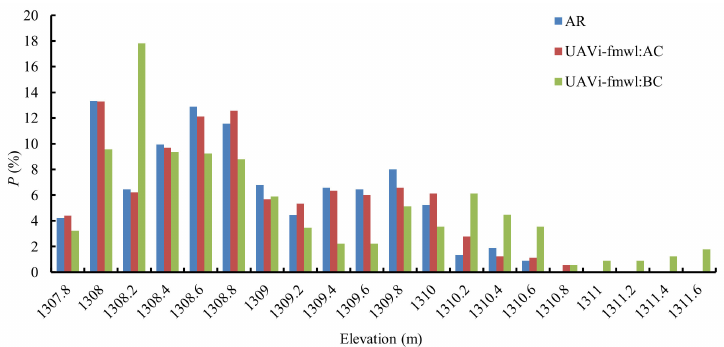
Figure 12. Probability density distribution of AR data and UAVi-fmwl data (three cases).